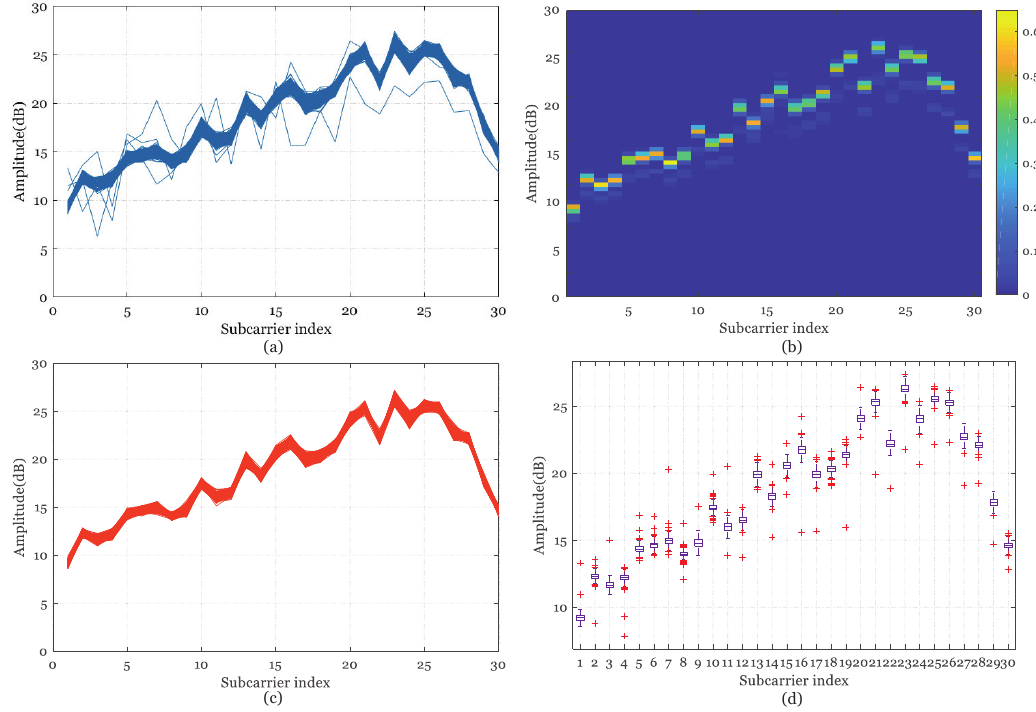
Figure 1. Channel state information (CSI) amplitude outlier filtering processing at position 1 in scenario 1 (Spare room). ( a ) The Raw CSI amplitude. ( b ) The distribution heat map of the amplitude probability. ( c ) The Processed CSI amplitude. ( d ) The boxplot diagram of the measured CSI